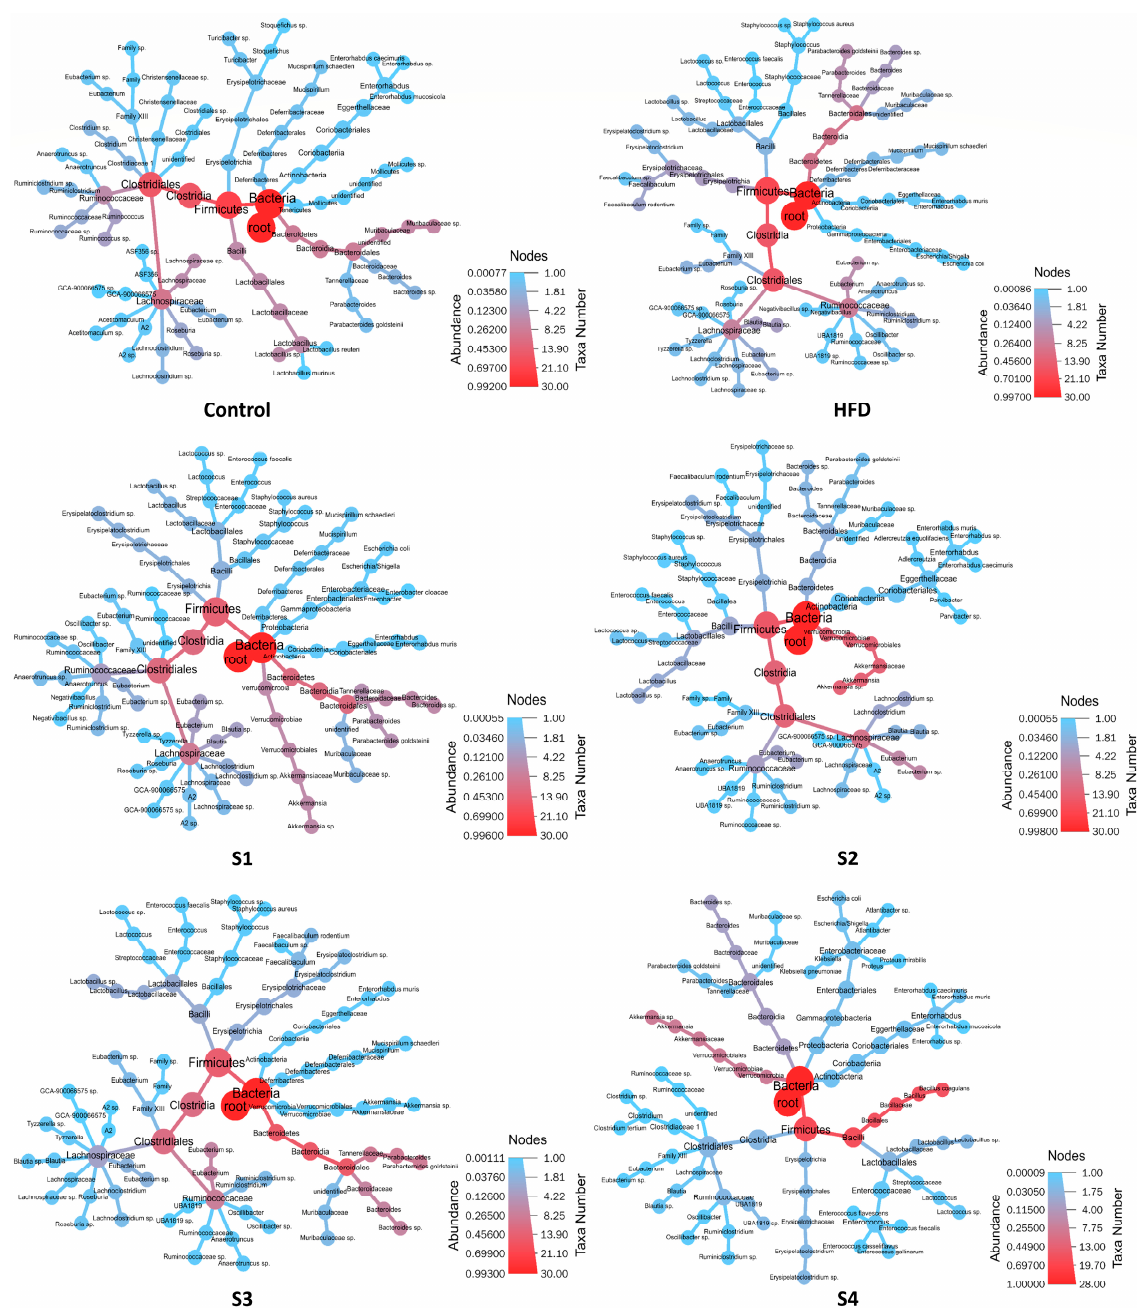
Figure 9. The effects of C. militaris on gut micriobiota composition in mice fed a high-fat/sucrose diet by Heat Tree plot. Differential taxonomic tree displaying the changes in taxa abundance between groups. Top 30 species for each group are